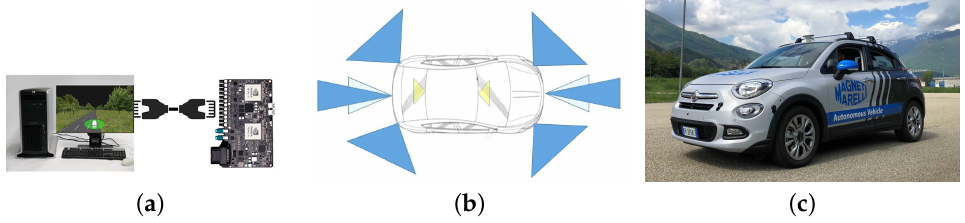
Figure 2. ( a ) The data fusion, planning and actuation module running on the PX2 NVIDIA GPU PG418 board and a desktop (or a laptop). ( b ) Sensors’ activity around the vehicle. ( c ) The final car configuration with on-board hidden